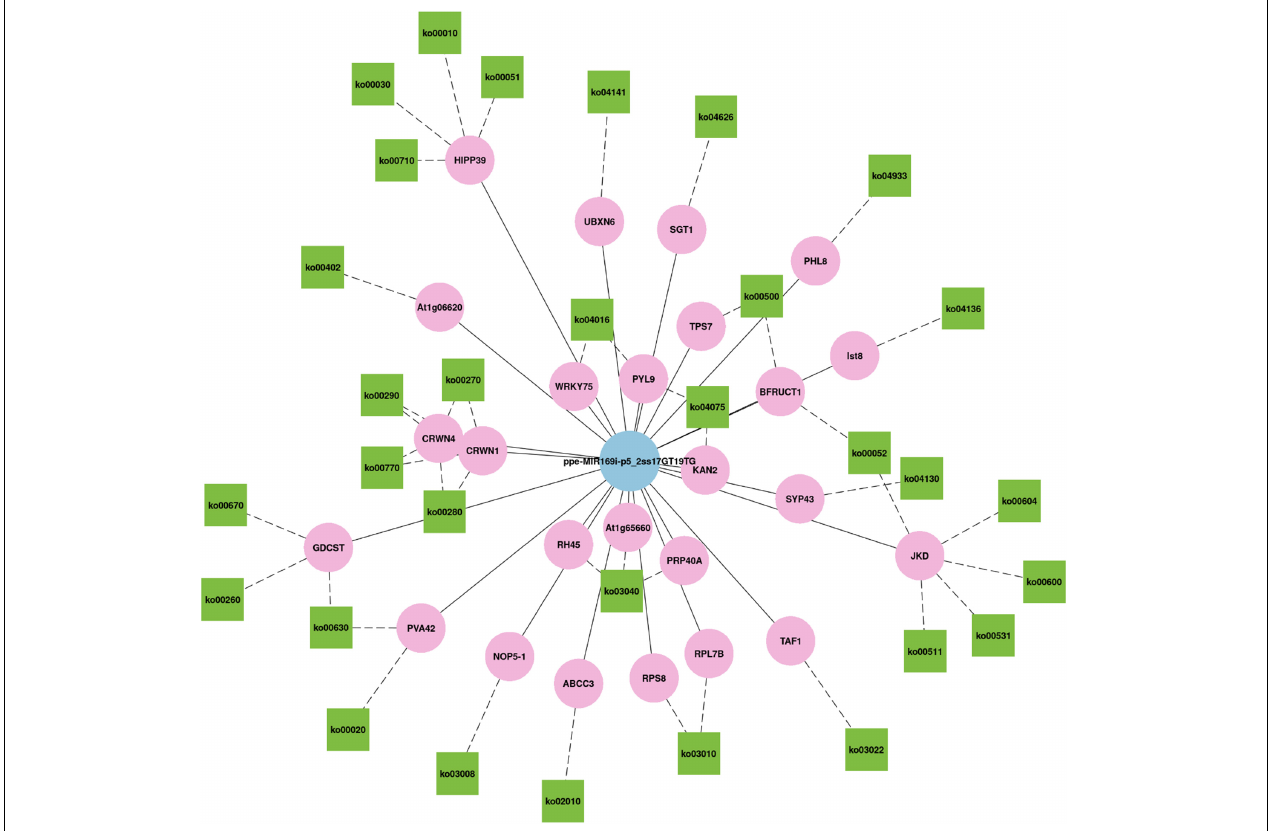
FIGURE 8 | The network plot for the target genes of ppe-MIR169i-p5_2ss17GT19TG and their KEGG